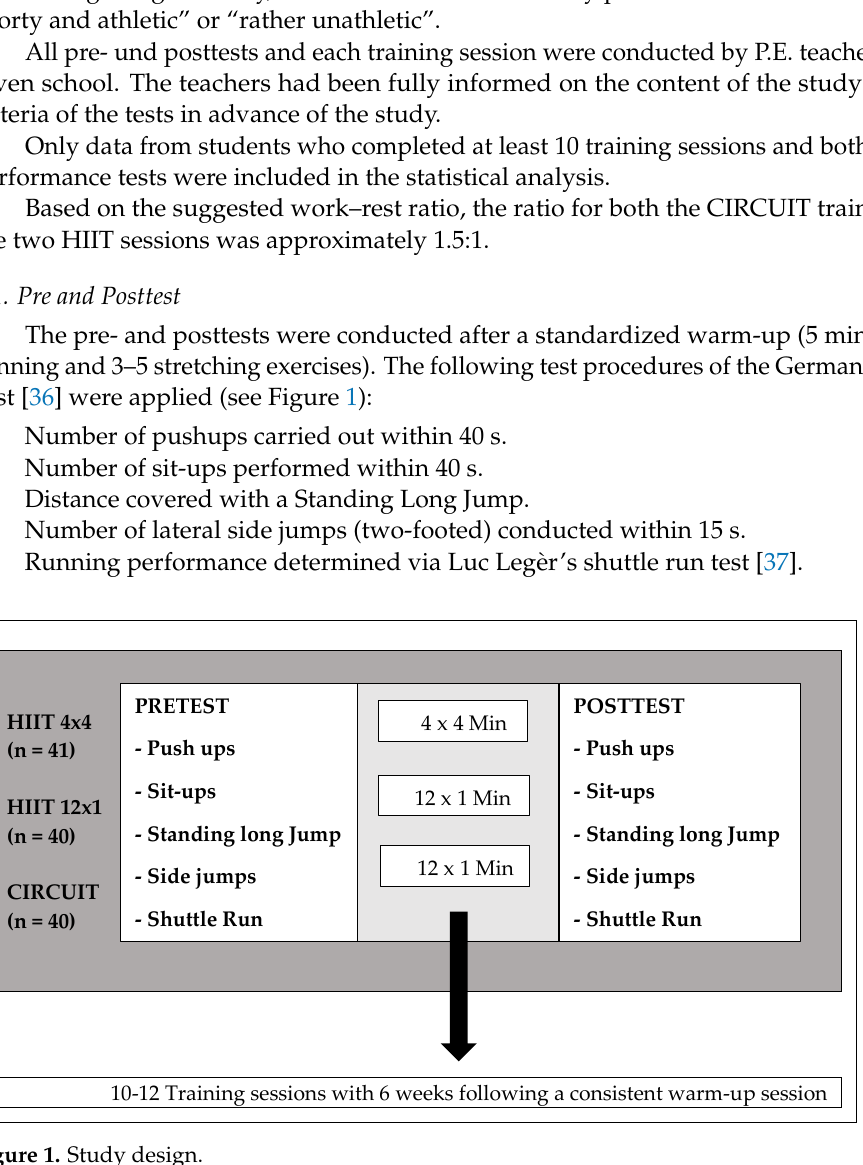
Figure 1. Study Figure 1. Study design.